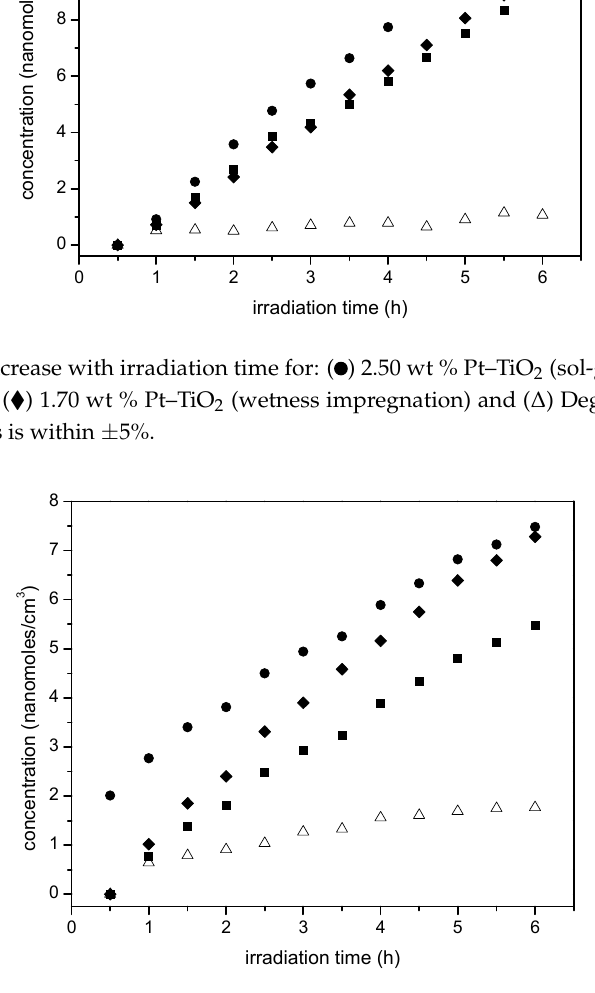
Figure 15. Acetaldehyde increase with irradiation time: ( ● ) 2.50 wt. % Pt–TiO 2 (sol-gel B), ( ■ ) 1.70 wt. % Pt–TiO 2 (sol-gel A), ( ♦ ) 1.70 wt. % Pt–TiO 2 (wetness impregnation) and ( ∆ ) Degussa P25. Standard deviation for repeats was within ±5%.